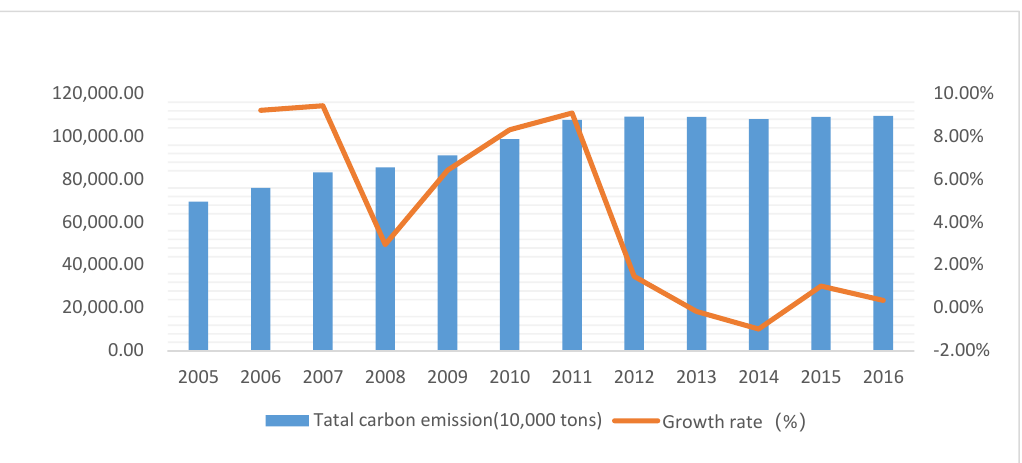
Figure 1. Growth trend of total carbon emission in the Yangtze River Economic Belt (YREB).